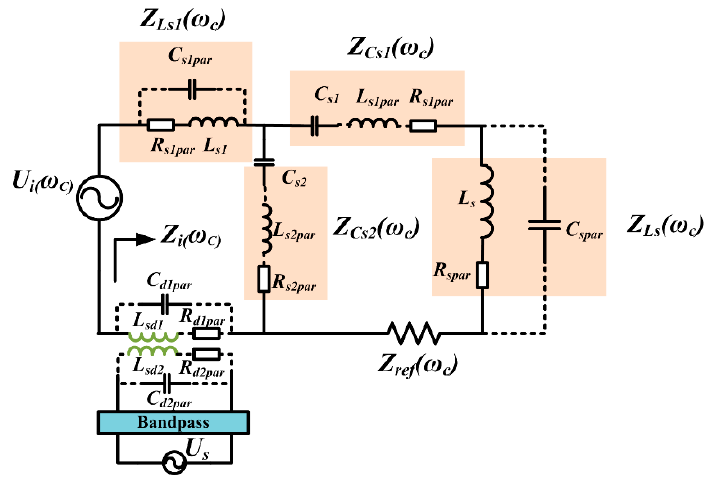
Figure 8. Diagram of the primary side of the proposed SWTPI system at the communication frequency. Resistor R d 1 par and capacitor C d 1 par can be neglected because the inductance of the signal coupling inductor L sd 1 is very